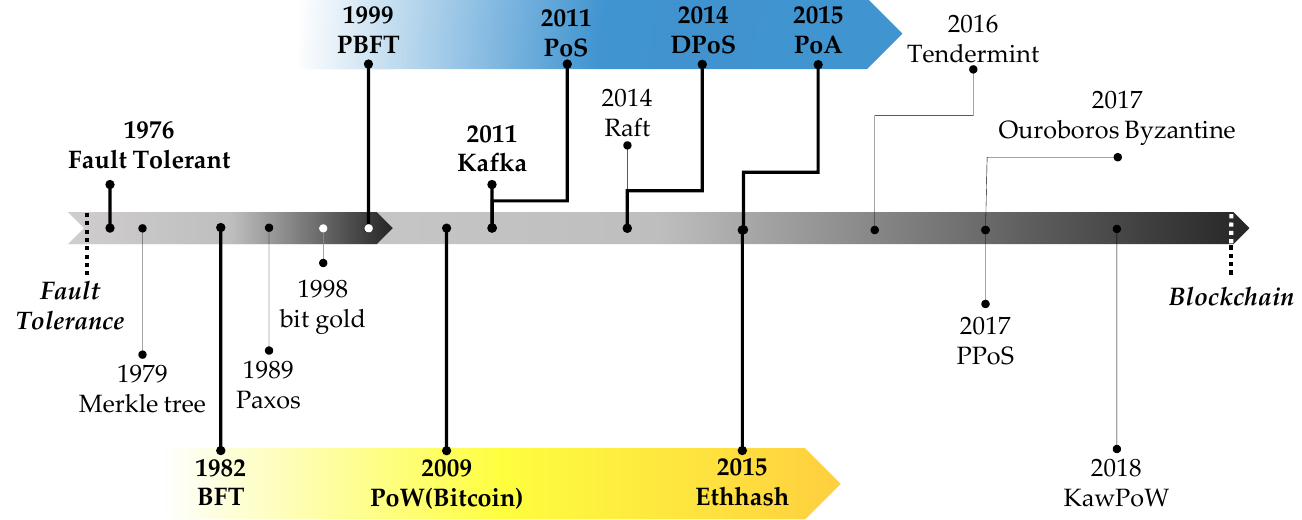
Figure 1. An evolutionary approach: sequential arrangement of well-known consensus algorithms.